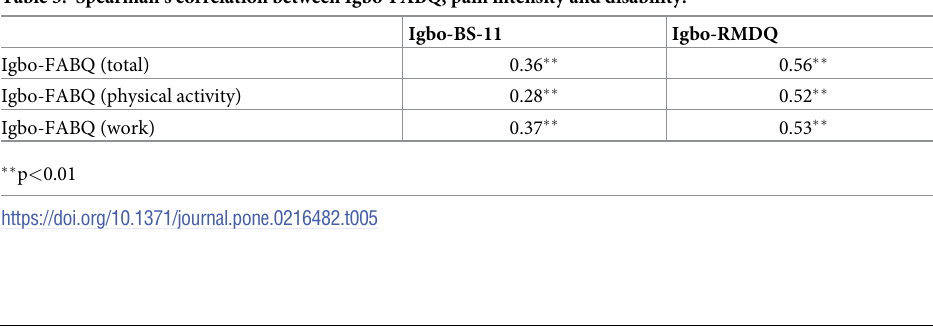
Table 5. Spearman’s correlation between Igbo-FABQ, pain intensity and